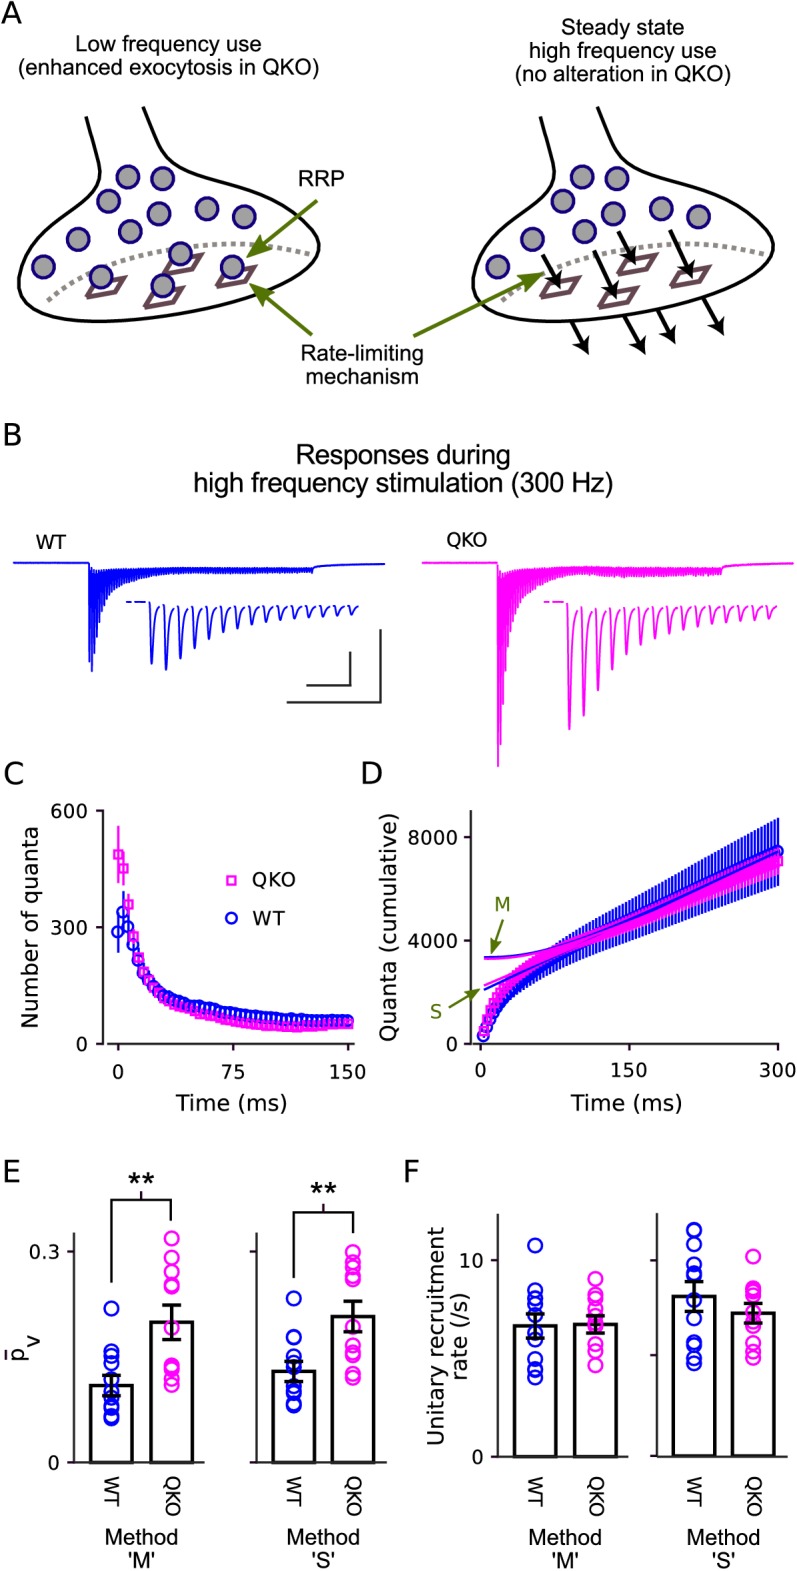
Selective increase in probability of release at QKO calyces of Held.(A) Diagram illustrating the RRP when nearly full during low-frequency stimulation (left) and when driven to a near-empty steady state by high-frequency stimulation (right). Gray circles represent vesicles, vesicles docked to release sites (squares) are readily releasable. By definition, the quantal content of individual synaptic responses is equal to the mean probability of release per vesicle within the RRP - p¯v - multiplied by the number of vesicles within the RRP. However, the precise value of p¯v ceases to be relevant when the RRP is driven to a near-empty steady state because vesicles undergo exocytosis soon after being recruited and, as a consequence, recruitment to the RRP (black arrows, right panel) supplants vesicle exocytosis as the rate-limiting mechanism. (B) Average response across all calyces during 300 ms of 300 Hz stimulation after blanking stimulus artifacts. Scale bars are 1 nA vs 100 ms (outer) and 1 nA vs 10 ms (inner, corresponding to the insets showing first 15 responses). (C) Mean number of quanta for each response vs time. Responses were first measured as the current integral after subtracting a baseline calculated from the 100 ms before stimulation began, and then normalized by mean quantal size. (D) Cumulative number of quanta. Theoretical curves are estimates of the cumulative response generated by release of transmitter recruited to the RRP during ongoing stimulation plus the offset needed to make the phase between 150 ms and 300 ms match the cumulative release; the value at Time = 0 equals the capacity of the RRP for storing vesicles. Lines marked ‘S’ are calculated using the method in Schneggenburger et al. (1999), whereas lines marked ‘M’ are calculated using Eqn (1) in Mahfooz et al. (2016), and describe the model illustrated in (A); note that both curves for both genotypes are plotted (magenta for QKO, blue for WT). The full 300 ms of 300 Hz stimulation elicited multiple rounds of exocytosis of readily releasable vesicles for both genotypes, including a total of 7076 ± 531 quanta at QKO synapses, which is more than double even the largest estimates of RRP content (ordinate intercept of ‘M’). (E) p¯v for calyces calculated using the theories in (D) to estimate vesicle recruitment (p < 0.01; rank sum; same preparations as Figure 2). (F) Unitary recruitment rate for individual calyces. The unitary recruitment rate is defined as the fraction of vacant space within the RRP replenished in a given amount of time; the concept is depicted by the black arrows in (A), right, and is analogous to a rate constant in first-order kinetics.